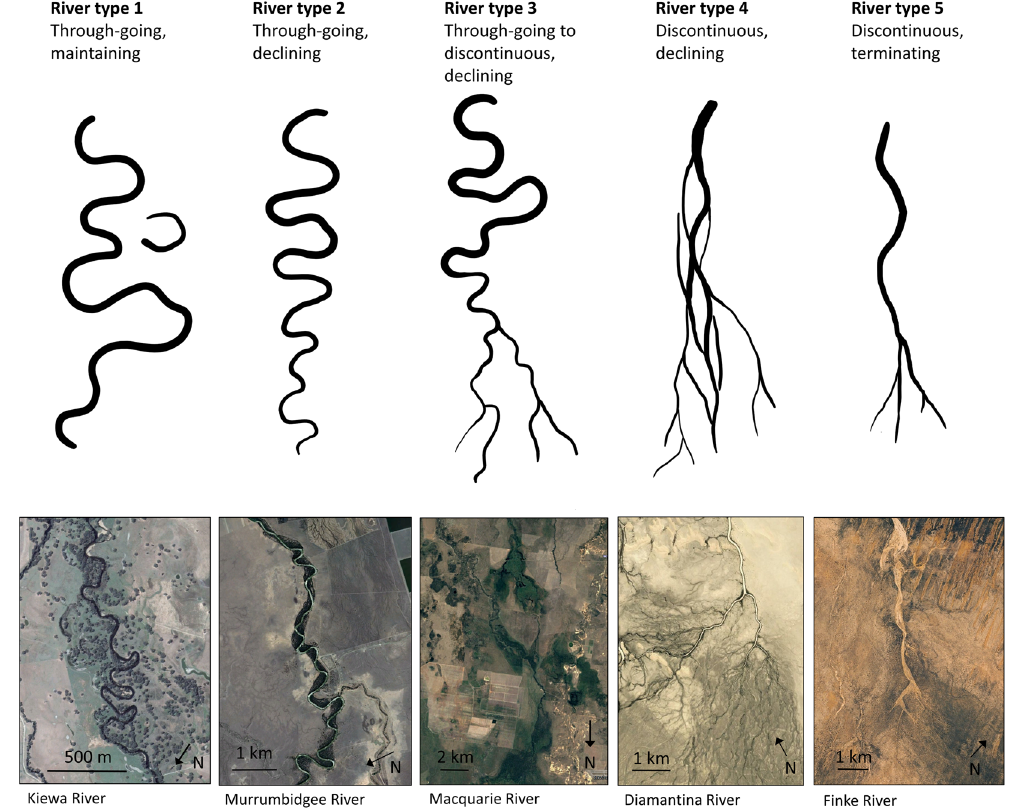
Figure 1. Schematic of the five dryland river types defined in this study, with satellite images of typical examples from various Australian rivers (Satellite imagery data: Google Earth, Image © 2017 Digital Globe, Image © 2017 CNES/Airbus). Flow direction is from top to bottom in all diagrams and